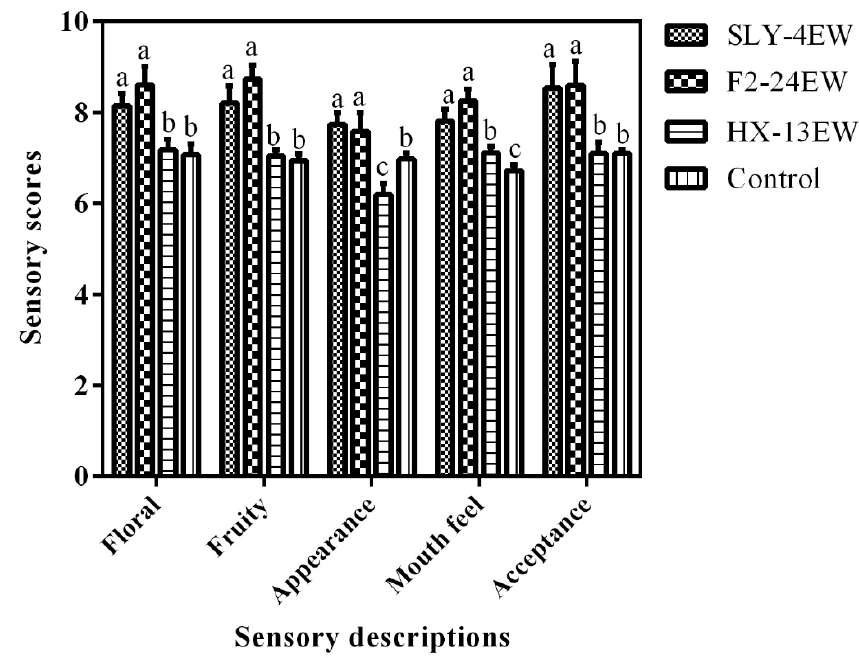
Figure 4. Sensory evaluation of wines treated by crude β -glucosidase from di ff erent non- Saccharomyces yeasts. Di ff erent letters within a cluster indicated di ff erences among wine samples determined by the Duncan test at a 95% confidence level. SLY-4EW: Wines treated by crude β -glucosidase from I. terricola SLY-4; F2-24EW: Wines treated by crude β -glucosidase from P. kudriavzevii F2-24; HX-13EW: Wines treated by β -glucosidase from M. pulcherrima HX-13; Control: Wines without enzyme treatment.